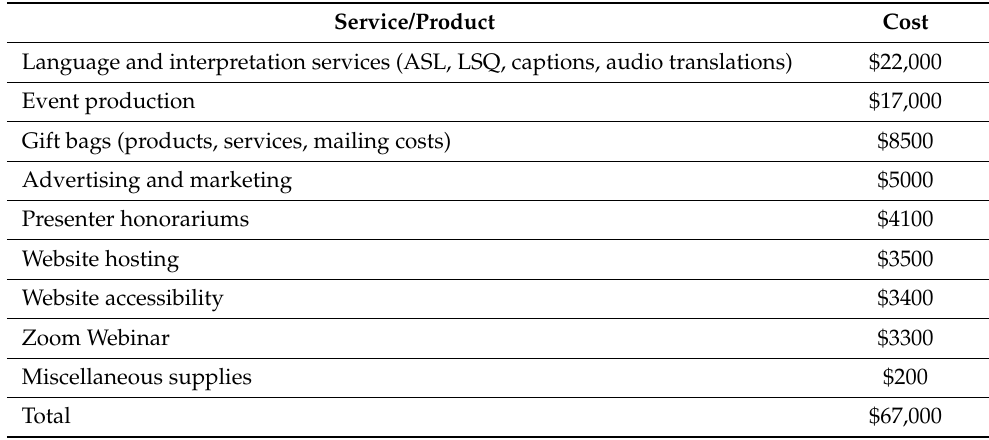
Table 3. Conference cost breakdown.